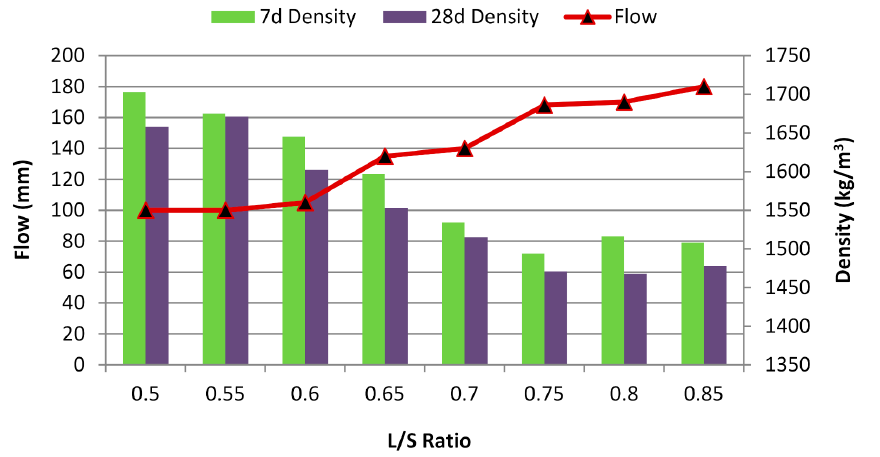
Figure 5. Flow of alkali-activated POFA paste at different L/S